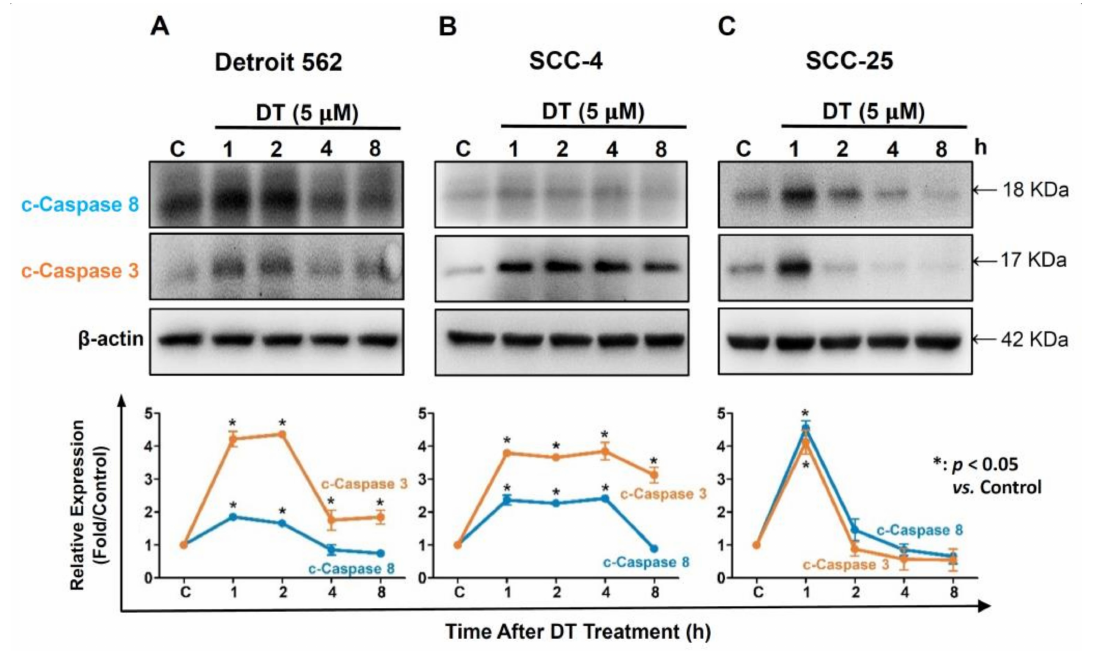
Figure 5. DT induced the cleavage of caspase-8 and caspase-3 in HNSCCs cells. Cleaved forms of caspase-8 and caspase-3 were increased in ( A ) Detroit 562, ( B ) SCC-4, and ( C ) SCC-25 cells after treatment with 5- µ M DT as determined by Western blotting. The fold changes were calculated from three independent experiments and are presented as means and standard errors of the mean. * indicates a statistically significant difference compared with untreated control cells.